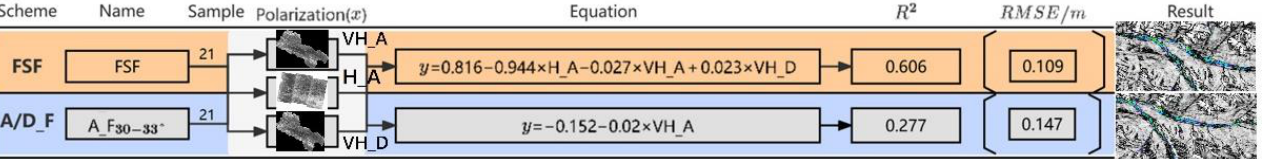
Figure 7. Stepwise regression fitting equations for the Babao River. H _A denotes the entropy of an ascending orbit image, VH_A denotes the VH polarization of an ascending orbit image, and VH_D is the VH polarization of a descending orbit image. The orange and blue colors indicate the methods with the best accuracy.